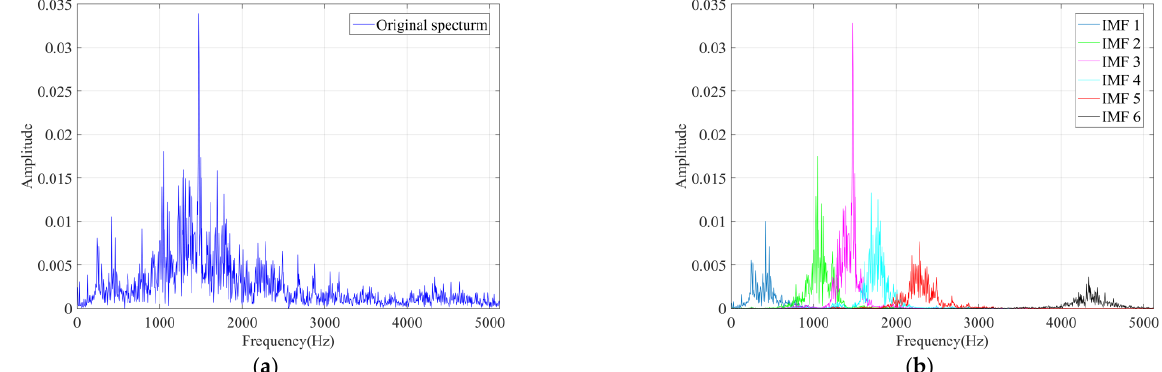
Figure 9. The frequency spectrum of normal bearing signal: ( a ) spectrum of original signal; ( b ) spec- trum of each component.